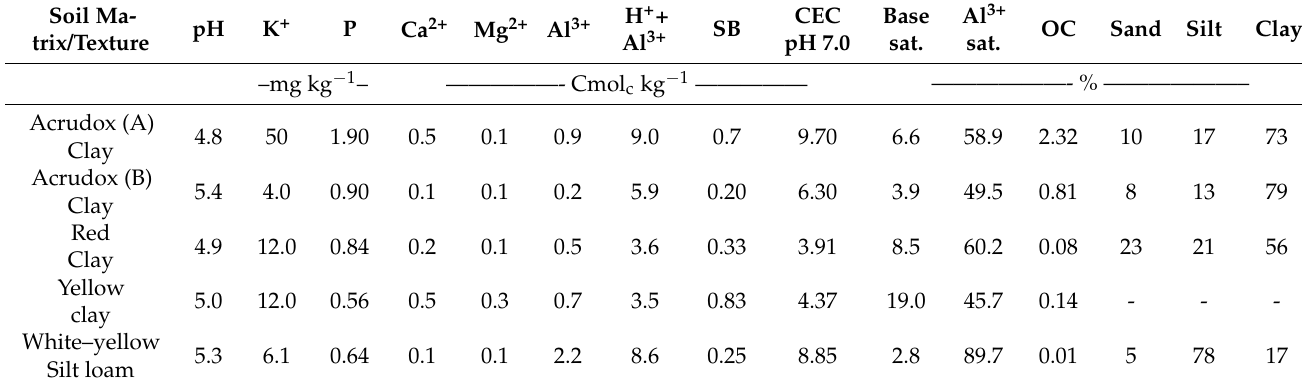
Table 2. Chemical and particle-size characterization of the B horizon of the overlying Anionic Acrudox and the different-colored matrices of the Paleosol.